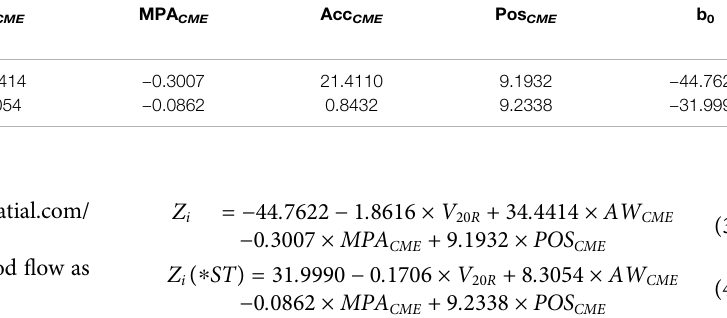
TABLE 1 | The resulting logistic regression coef fi cients following the non-linear logistic regression model for normalized values ( fi rst row) and for standardized values (second row). Indenpendent variable/coef fi